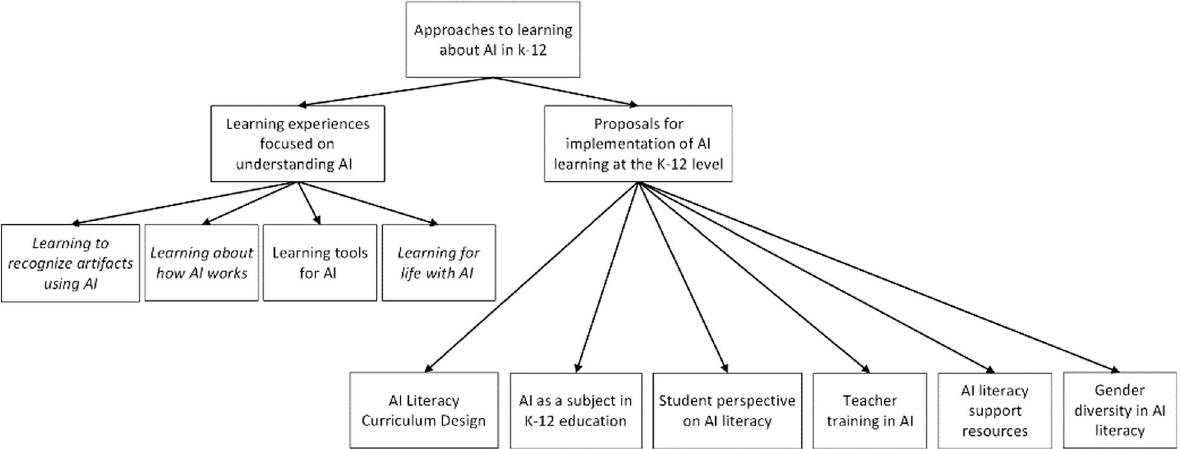
Fig. 6 Taxonomy of approaches to AI learning in